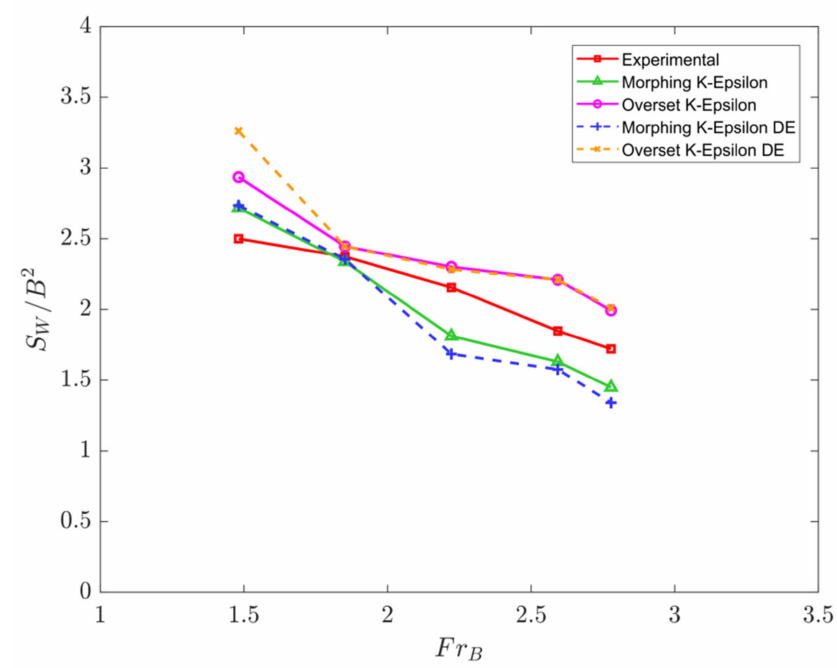
Figure 10. As of Figure 6, but for the wetted